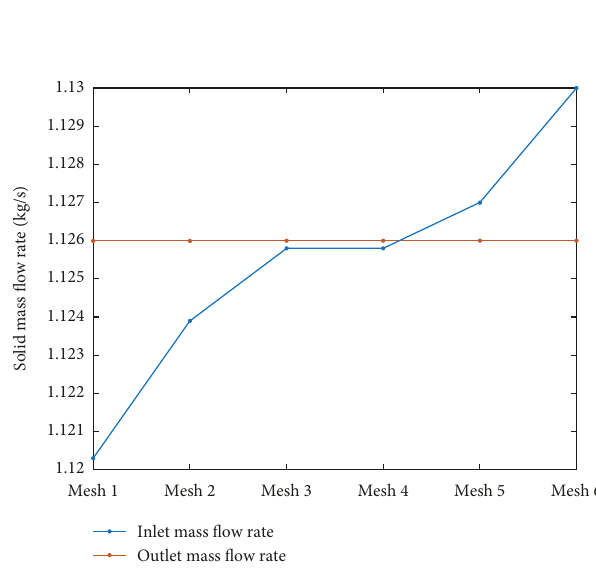
Figure 4: Solid mass flow rate comparison for different meshes. The number of elements in each mesh is given in Table